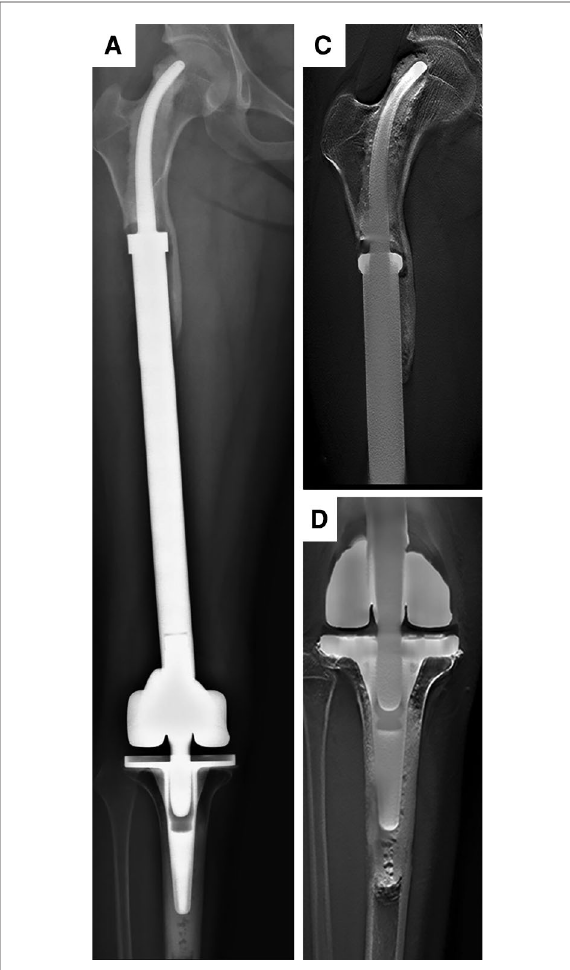
FIGURE 4 Radiographs showing the 102-month postoperative views of the customized cemented femoral endoprosthesis with an intra-neck curved stem placed during treatment for an osteosarcoma. ( A ) Posteroanterior radiograph of the entire femur. ( B ) Posteroanterior with Shimadzu Metal Artefact Reduction Technology ( T -smart) views of the stem insertion region in the proximal femur. ( C ) Posteroanterior T -smart views of the stem insertion region in the proximal tibial.